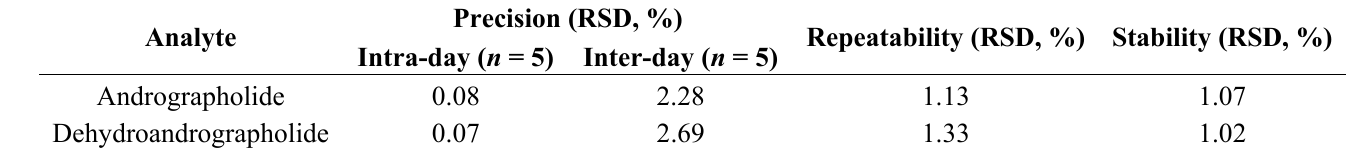
Table 2. Results of precision, repeatability and stability tests.